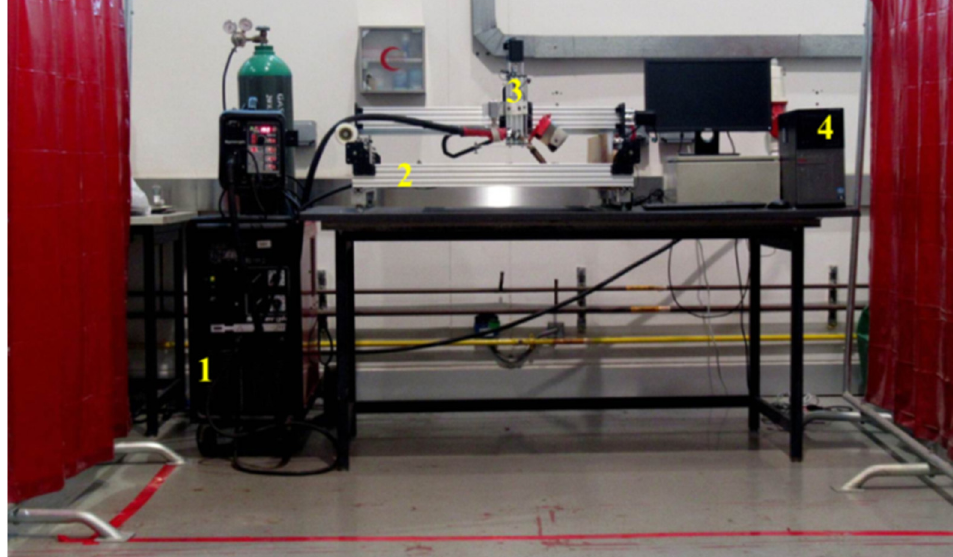
Figure 2. Welding apparatus—1. weld machine with the controller; 2. self ‐ build table CNC machine; 3. Z ‐ axis coupled with weld torch; 4. personal computer.